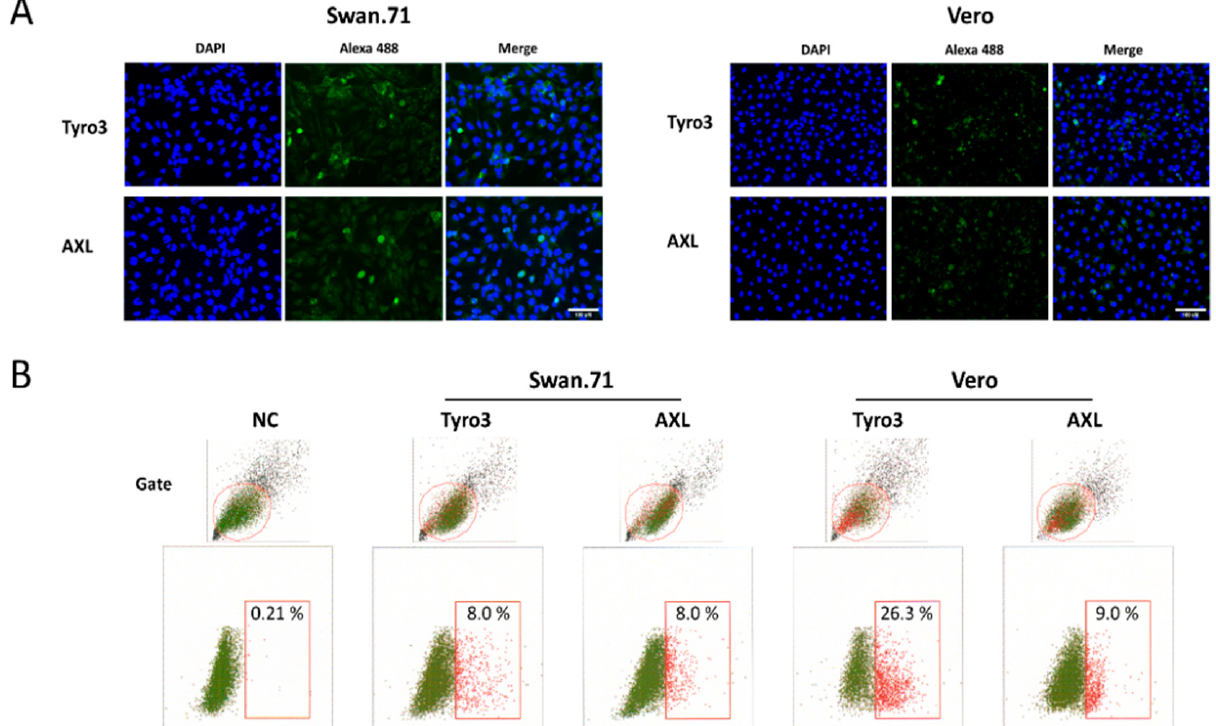
Figure 1. Expression of Tyro3 and AXL on the surface Swan.71 cells. ( A ) Immunofluorescence assay. The cells were cultured on glass coverslips in 6-well plates and stained for Tyro3 or AXL. Scale bar: 100 µ M. ( B ) Flow cytometry analysis. Trophoblast cells were cultured in a 96-well plate and stained for Tyro3 or AXL. Numbers displayed inside each panel correspond to the percentage of positive cells for Tyro3 or AXL of the parent-gated population. ( A , B ) Data obtained from Vero cells performed in parallel were used as comparative references.